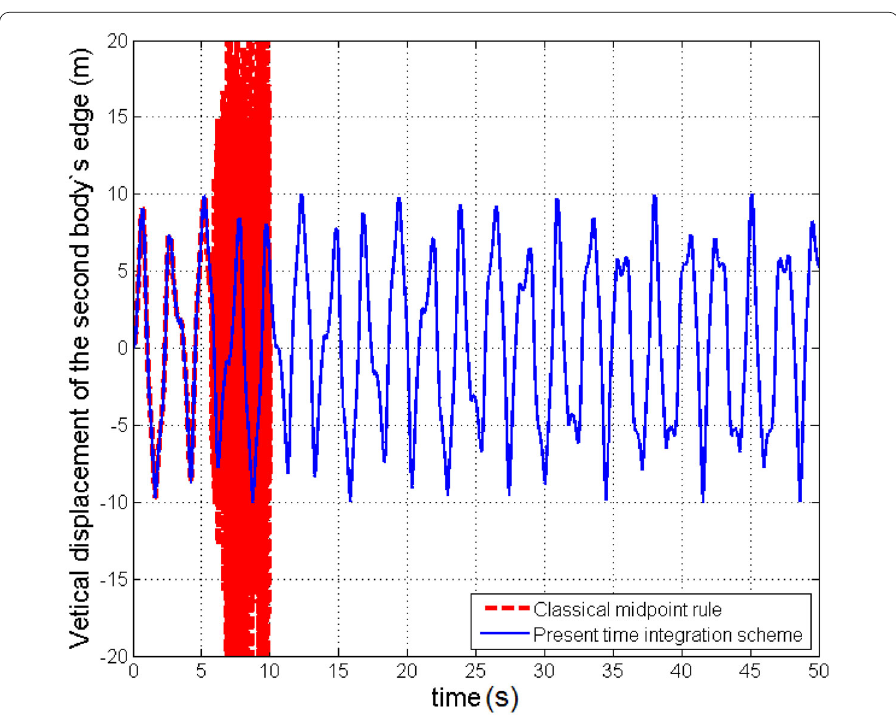
Fig. 9 Vertical displacement of second body‘s edge for (cid:15) t = 10 − 2 s